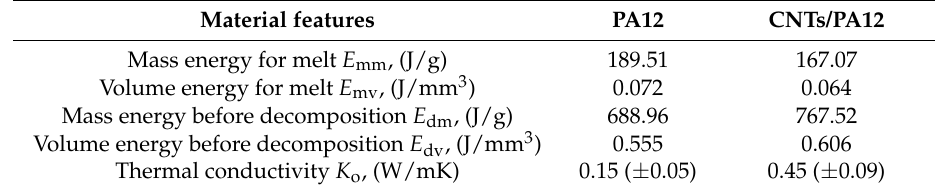
Table 4. Evaluation of energy required for melting and energy absorbed before polymer degradation with respect to the specific mass and volume; the measured thermal conductivities of PA12 and CNTs/PA12 parts.